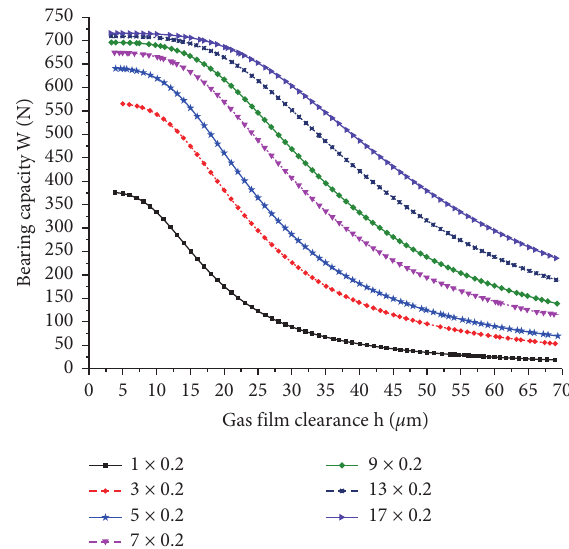
Figure 6: Curve of influence of the number of orifices n on the bearing